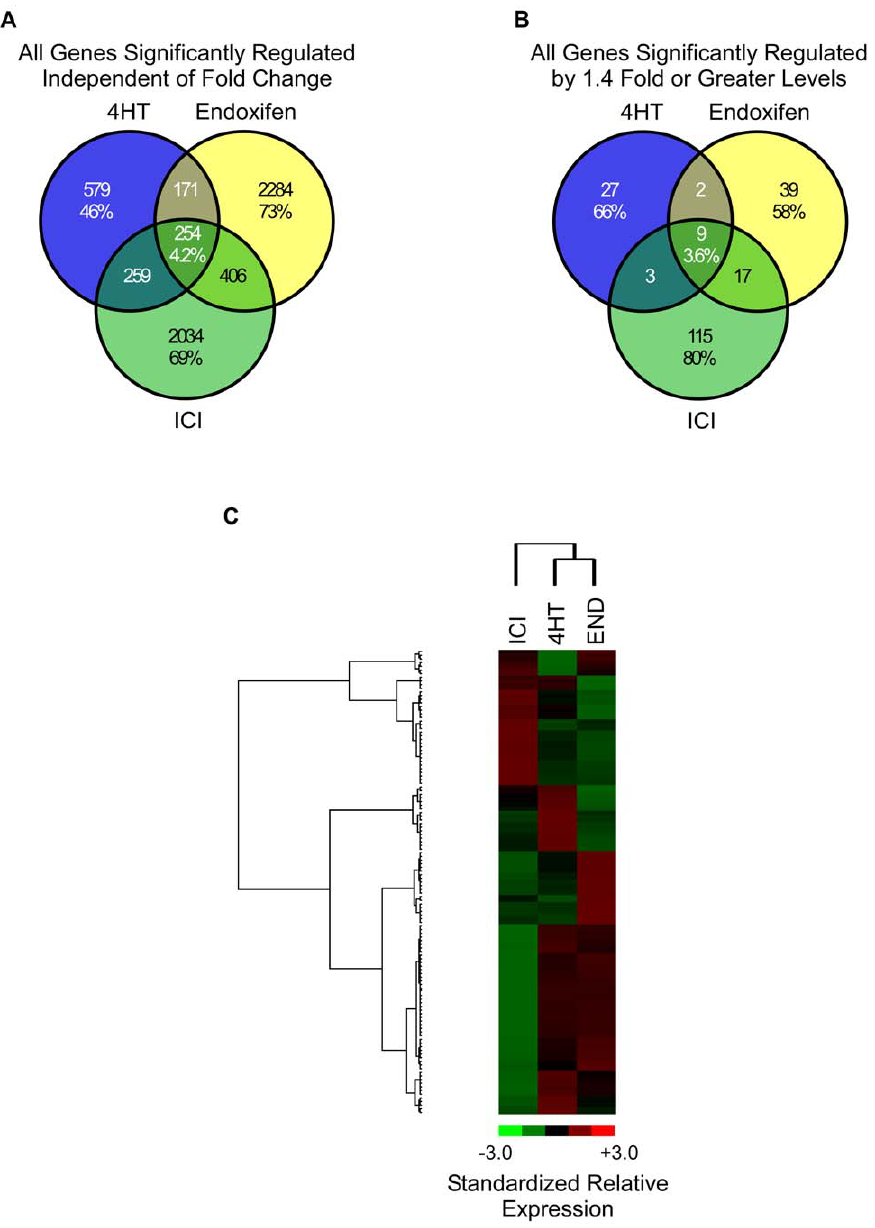
Figure 5. Microarray analysis of 4HT, endoxifen and ICI action in the absence of estrogen. ( A ) Venn diagram of genes whose expression levels were determined to be significantly altered by 100 nM concentrations of 4HT, endoxifen or ICI in the absence of estrogen following 24 hours of regardless of fold-change levels. ( B ) A second Venn diagram was developed using only those genes which exhibited fold-changes of 1.4 fold or greater relative to vehicle treated control cells. ( C ) Heat map depicting the hierarchical clustering of genes that were differentially expressed in at least one of the indicated treatment groups relative to vehicle control and which had average fold-changes . 3 standard deviations from all other genes in the comparison. Red indicates increased gene expression while green indicates decreased gene expression relative to vehicle treated controls.